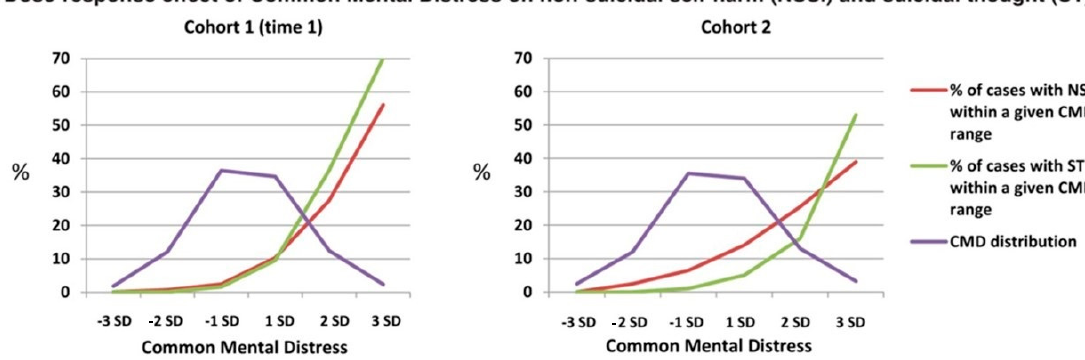
Figure 1. Dose-response effect of common mental distress on non- suicidal self- injury (NSSI) and suicidal thought (ST) in cohort 1 and cohort 2. The normal population distribution of CMD, which was strikingly similar, but not identical, in cohorts 1 and 2, is shown by the purple line. CMD, common mental distress. (Reproduced from Polek 2020 [69] with permission).